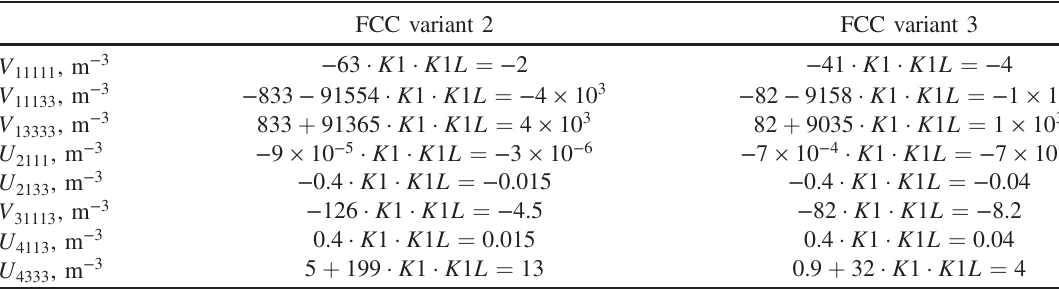
TABLE IX. Comparison of the map coefficients for FCC-ee variants 2 and 3.